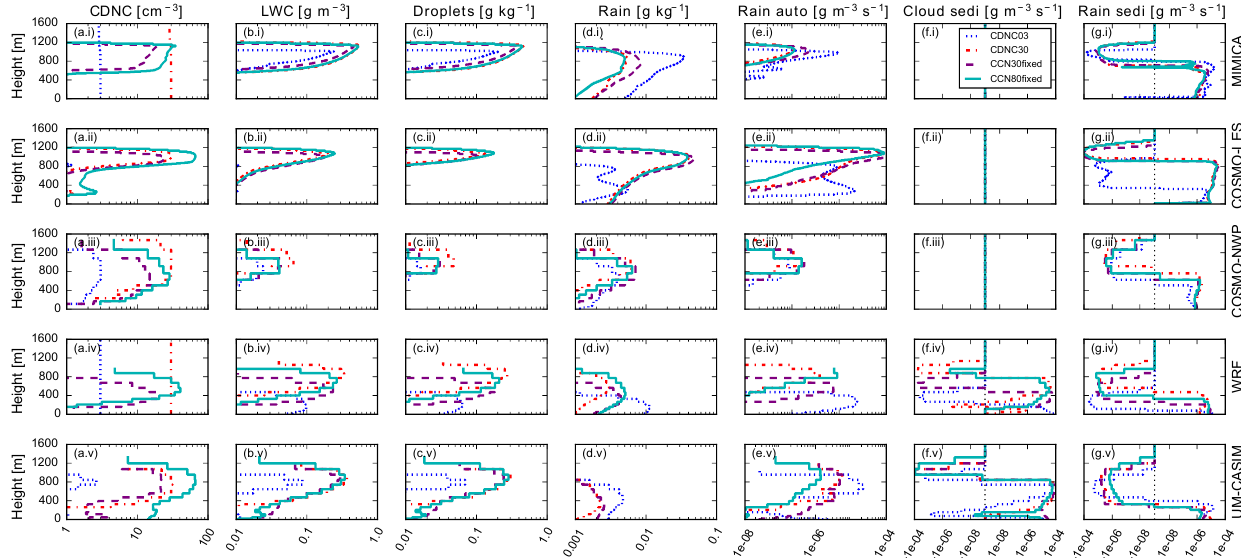
Figure 7. Time-averaged profiles of cloud properties and tendencies due to liquid-phase processes for simulations with no cloud ice permitted. The first letter in subplot labels refers to column and the second to the row. (a) Cloud droplet number concentrations. (b) Liquid water contents. (c) Cloud droplet mass mixing ratios. (d) Rain mass mixing ratios. Rightmost three columns: tendencies of mixing ratios of cloud droplets or rain due to autoconversion of cloud droplets to rain (e) , sedimentation of cloud droplets (f) , and sedimentation of rain (g) . Results are shown (from top to bottom) from the MIMICA (i) , COSMO-LES (ii) , COSMO-NWP (iii) , WRF (iv) , and UM-CASIM (v) models. The blue dotted line indicates the CDNC03 case, the red dash-dotted line indicates the CDNC30 case, the purple dashed line indicates the CCN30fixed case, and the solid turquoise line indicates the CCN80fixed case. Note that only WRF and UM-CASIM simulate the sedimentation of cloud